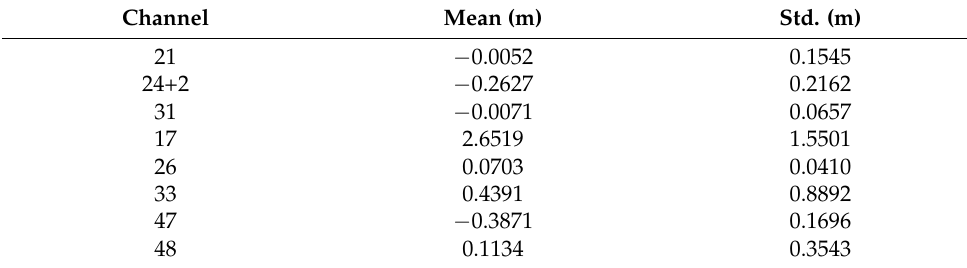
Table 2. Error metrics of static field